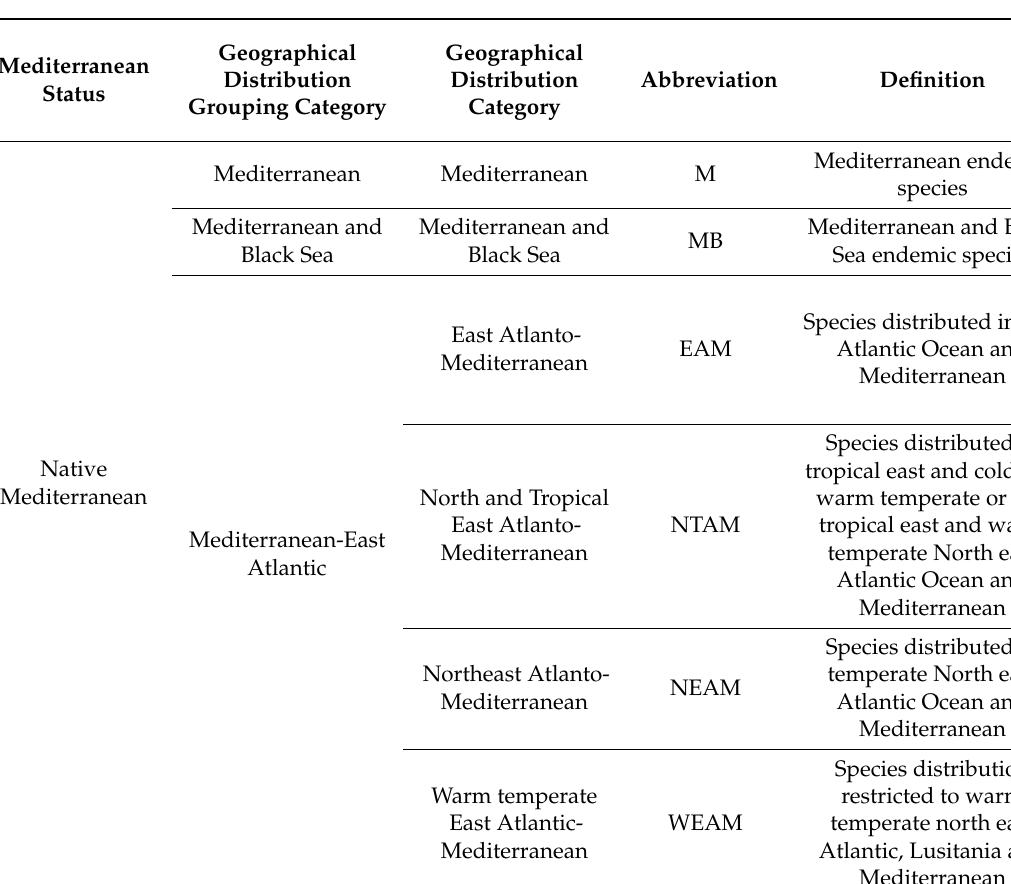
Table 1. The geographic distribution categories and definitions. The abbreviations consist of the first letters of geographic distribution categories for later use in the text and tables. Coastal and Shelf Realms in bold and Provinces in regular. The bathyal province codes are from Watling et al. [24] and explained by the accompanied province